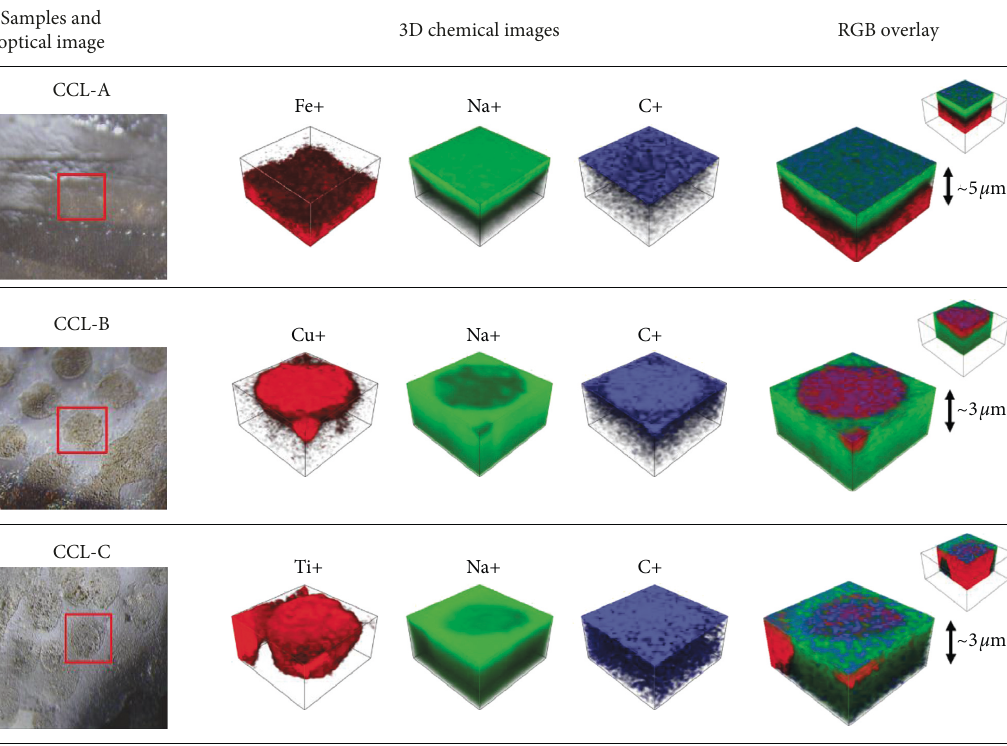
Samples and optical image